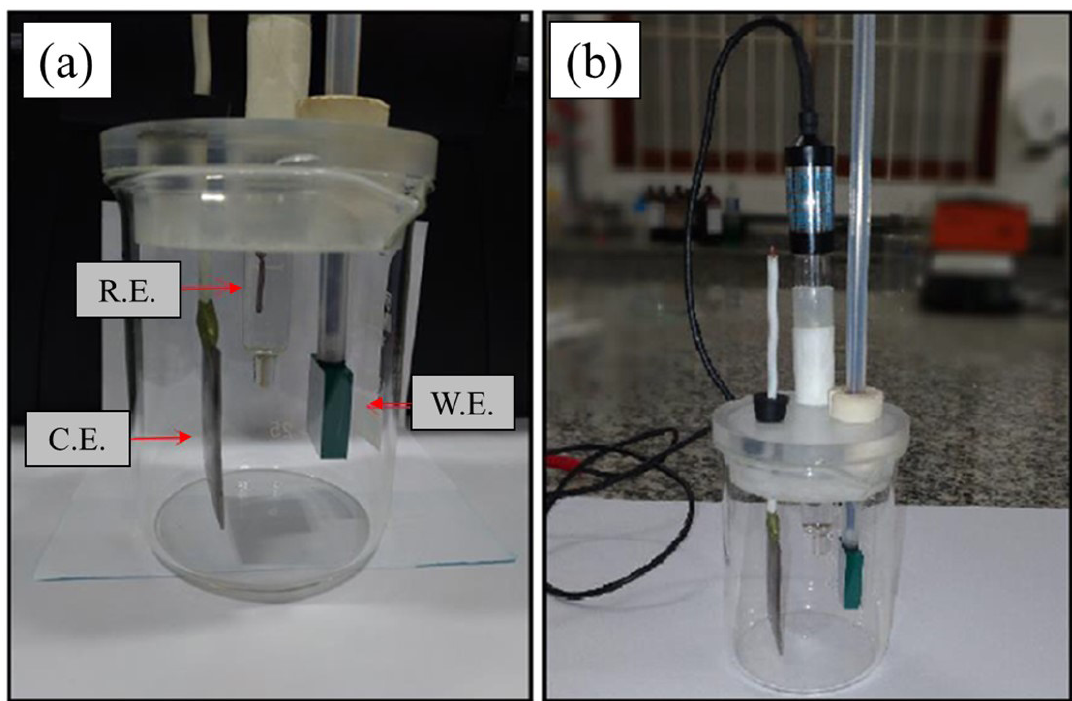
Figure 1. (a) Example of electrodeposition cell presenting the positioning of the working electrode (W.E.), counter electrode (C.E.), and reference electrode (R.E.) and (b) overall cell